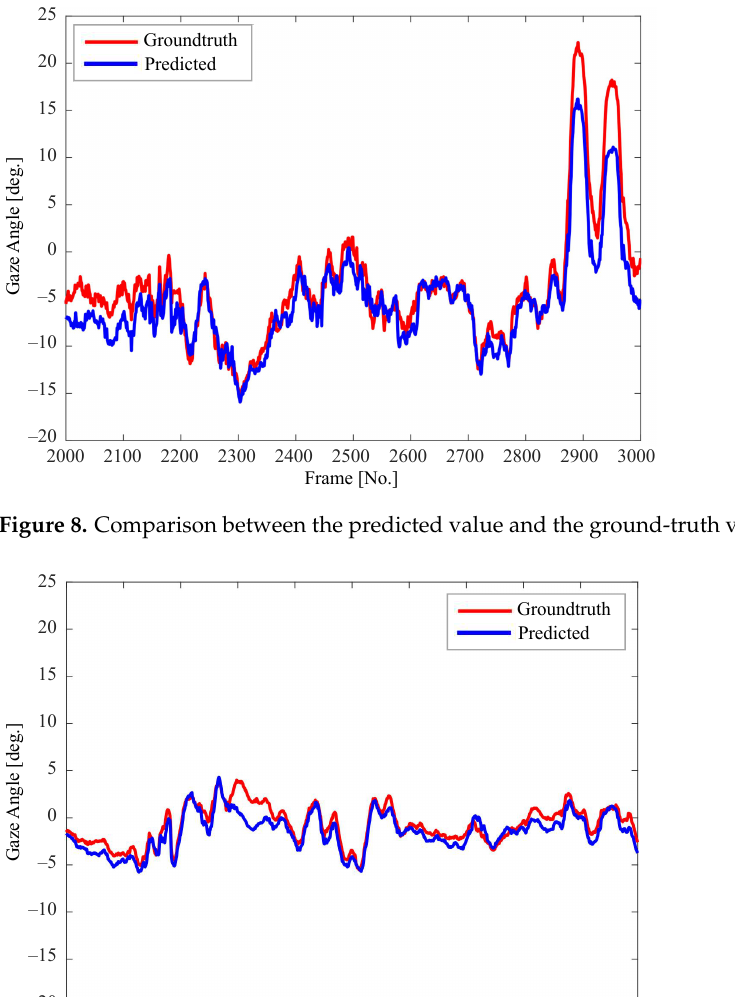
Yaw Figure 7. Comparison between the predicted value and the ground-truth value of yaw angle.